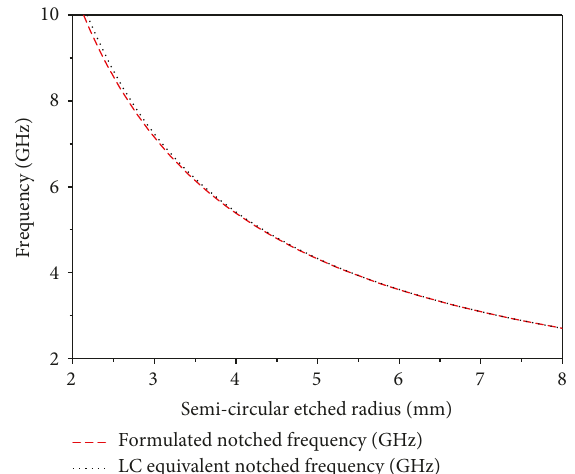
Figure 2: Graph of a formulated ( f frequency with respect to semicircular etched radius based on equations (1) and